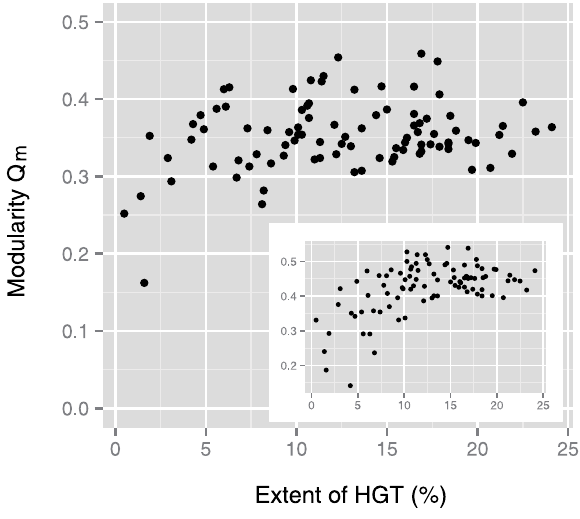
Figure 2. Correlation between the extent of horizontal gene transfer (HGT) and network modularity. Metabolic networks constructed from the latest version of the database show no correlation (Spearman’s rank correlation coefficient r s =0.15 and p =0.15). Meta- bolic networks constructed from the early version of the database (inset) demonstrate a positive correlation ( r s =0.41 and the associated p =4.8 6 10 2 5 ).